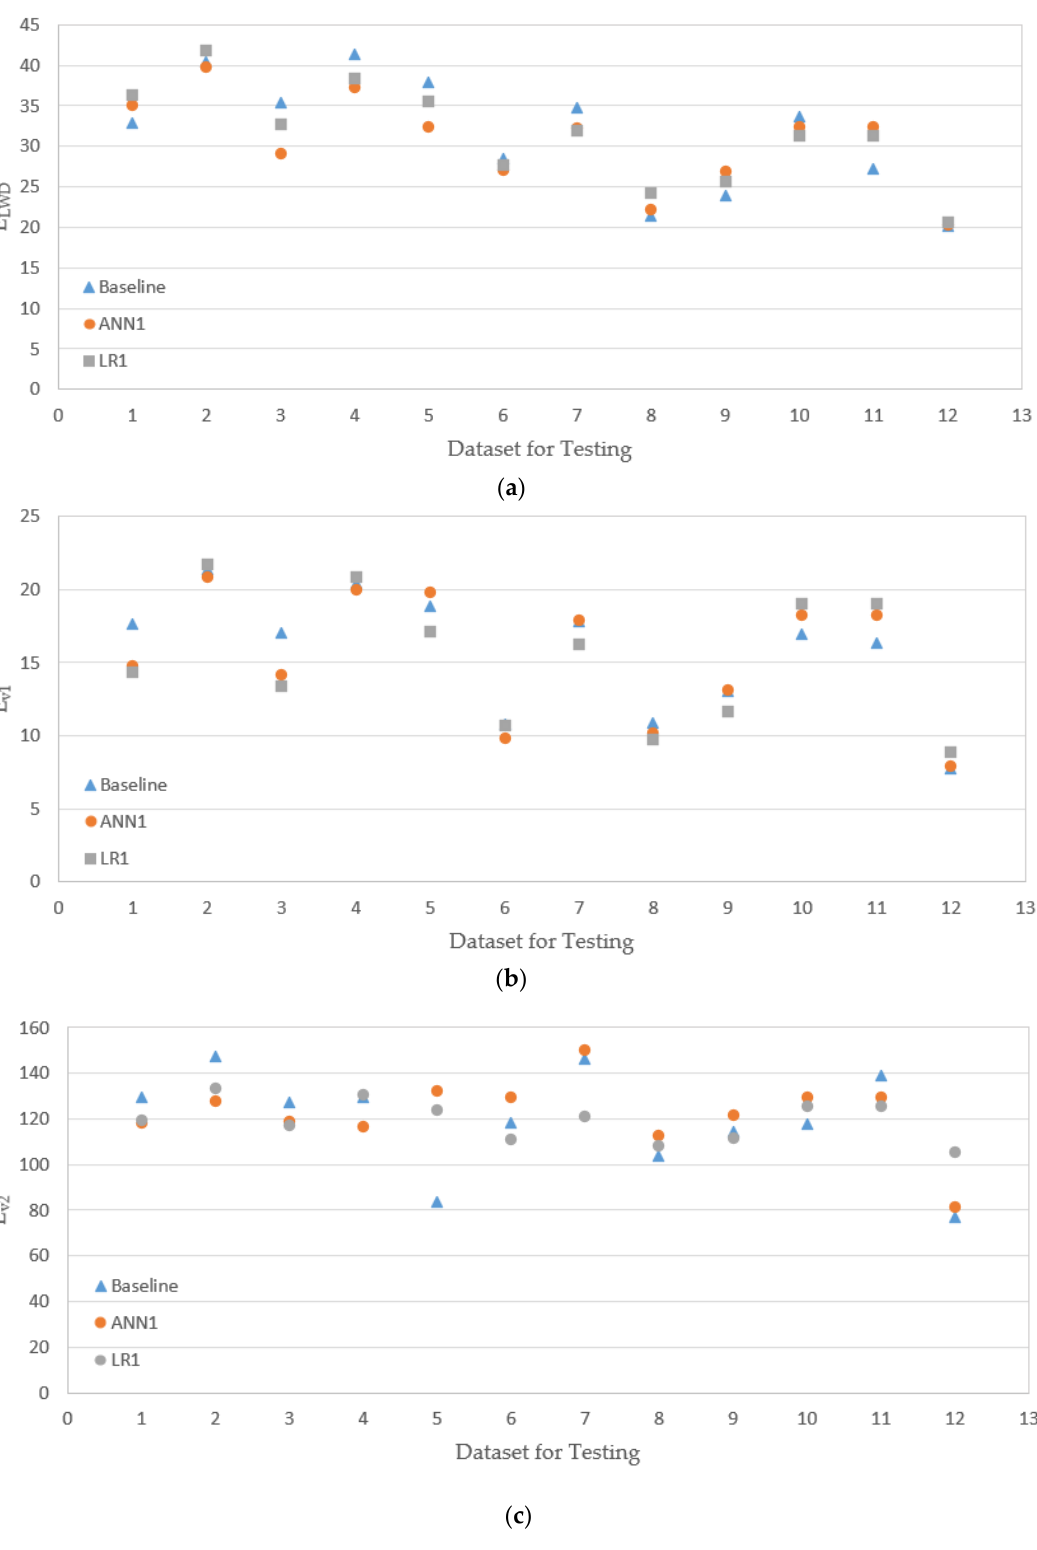
Figure 13. Testing results 1 (results of ANN are based on the model ANN1, and results of LN are based on the model LN1). ( a ) Testing results from E LWD ; ( b ) testing results from E v1 ; ( c ) testing results from E v2 .